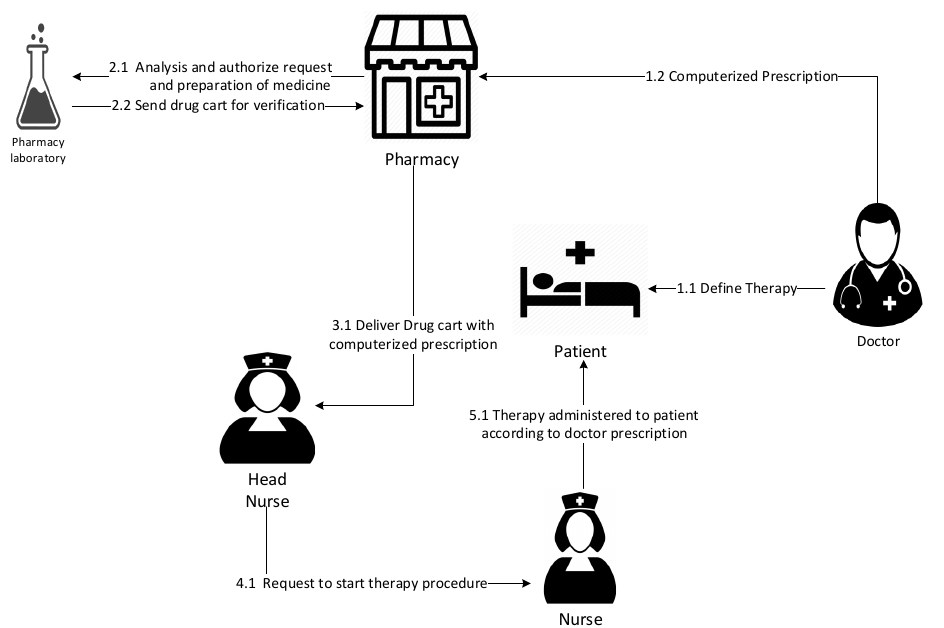
Figure 3. Structure of the proposed drug supply chain